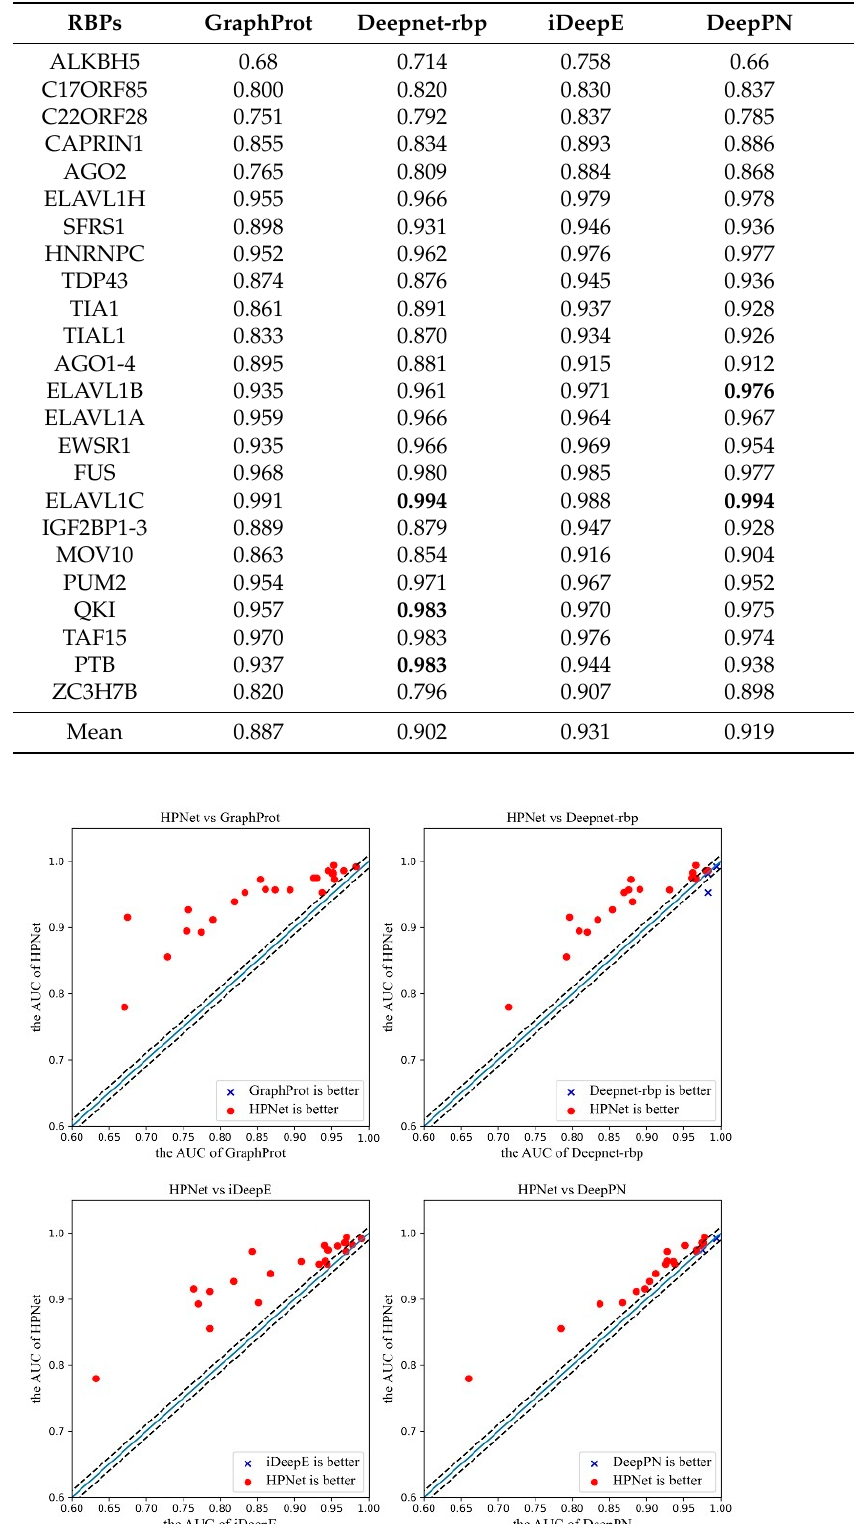
Table 2. Performance of HPNet and baseline methods with RBP-24 dataset.